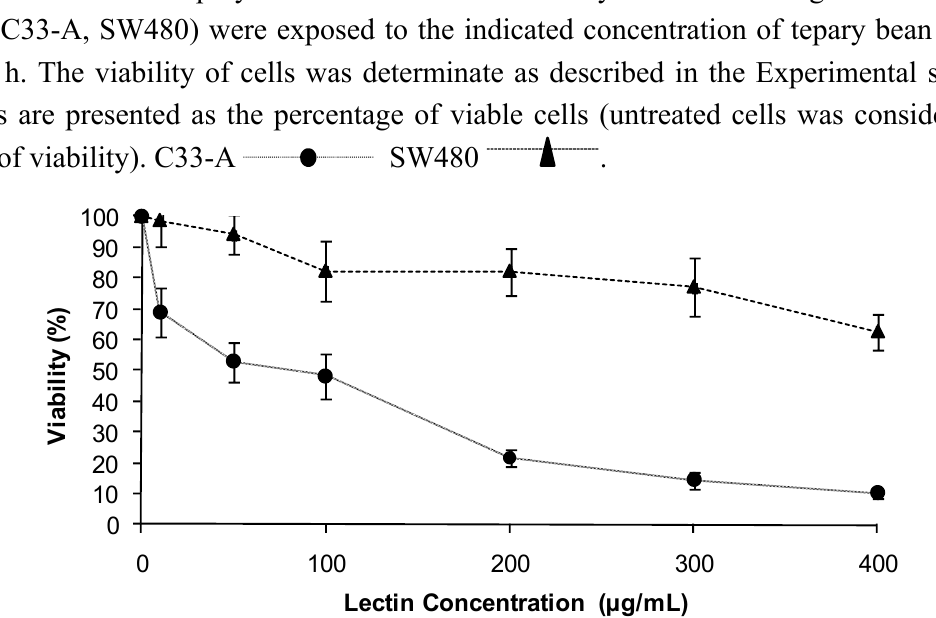
Figure 2. Effect of tepary bean lectins on the viability of human malignant cells lines. Cells (C33-A, SW480) were exposed to the indicated concentration of tepary bean lectins for 24 h. The viability of cells was determinate as described in the Experimental section. Results are presented as the percentage of viable cells (untreated cells was considered